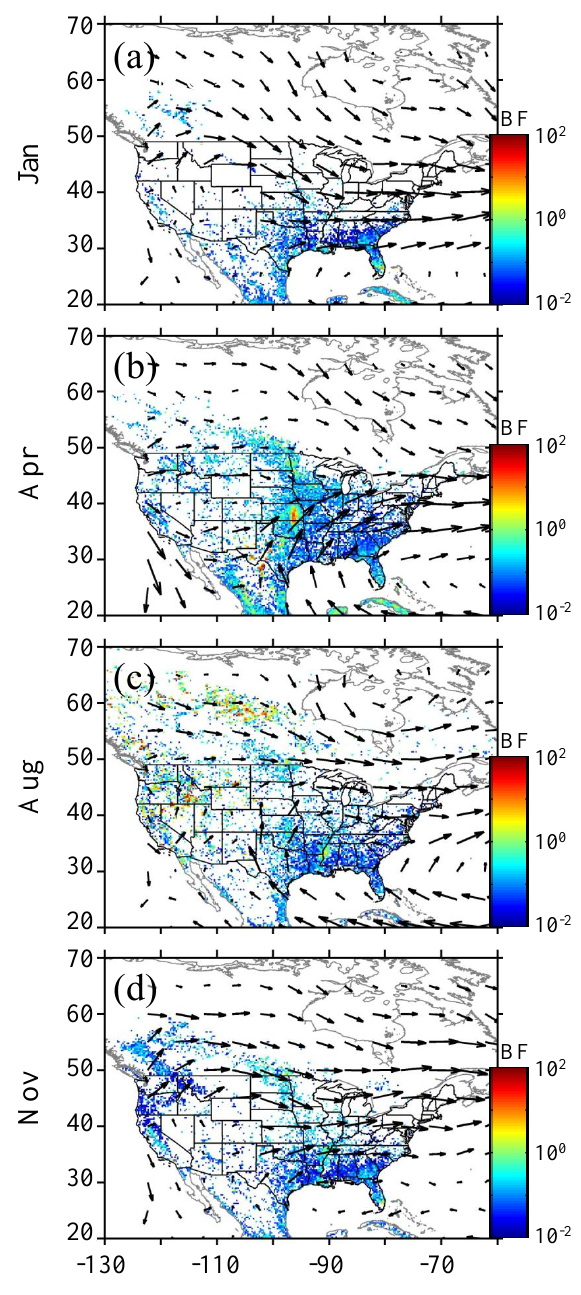
Figure 7. Burned fraction (BF) of each 0.25 ◦ × 0.25 ◦ grid cell and vector wind at 850mb averaged from 2008 to 2013 for (a) January, (b) April, (c) August and (d) November. The Global Fire Emissions Database Version 4 including small fires data (GFEDv4.1s; Ran- derson et al., 2015) was downloaded from the Oak Ridge National Laboratory Distributed Active Archive Centre (ORNL DAAC) for biogeochemical dynamics (https://daac.ornl.gov/cgi-bin/dsviewer.